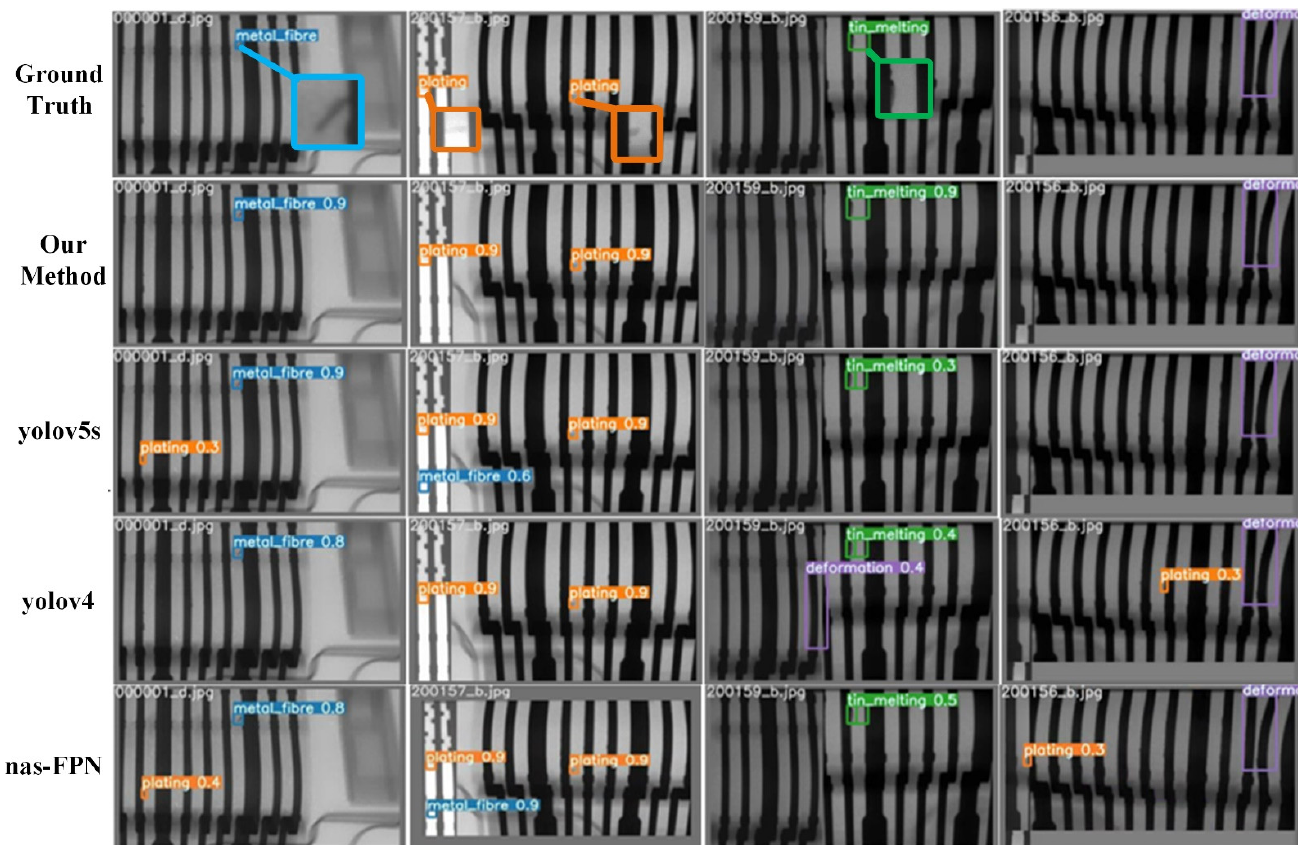
Figure 15. Comparison of the actual detection results of the experimental networks.